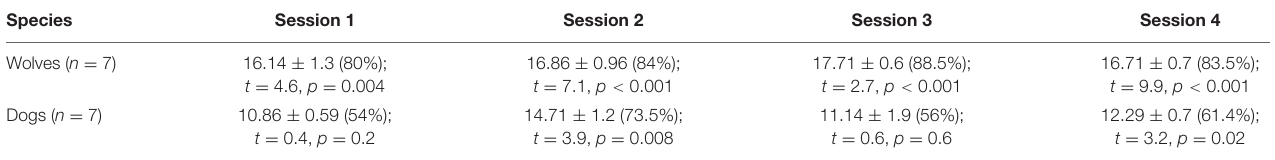
TABLE 6 | Wolves’ and dogs’ performance in test trials. Species